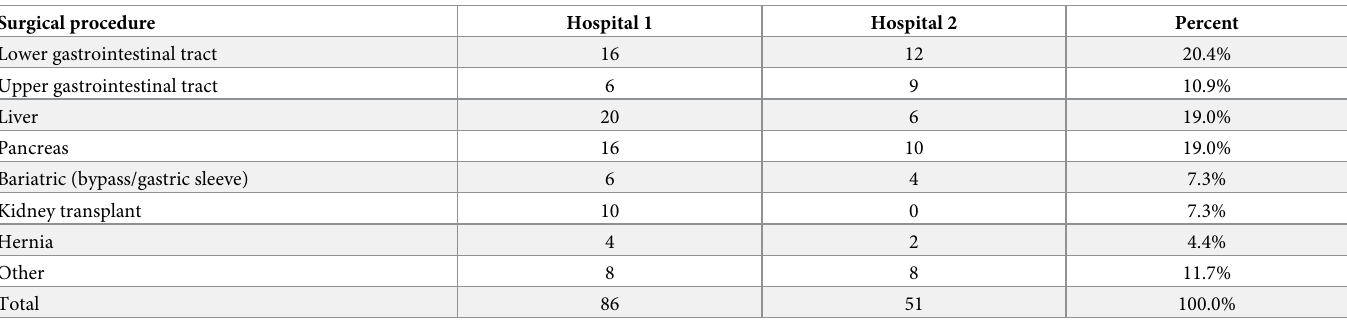
Table 1. Surgical procedures observed.